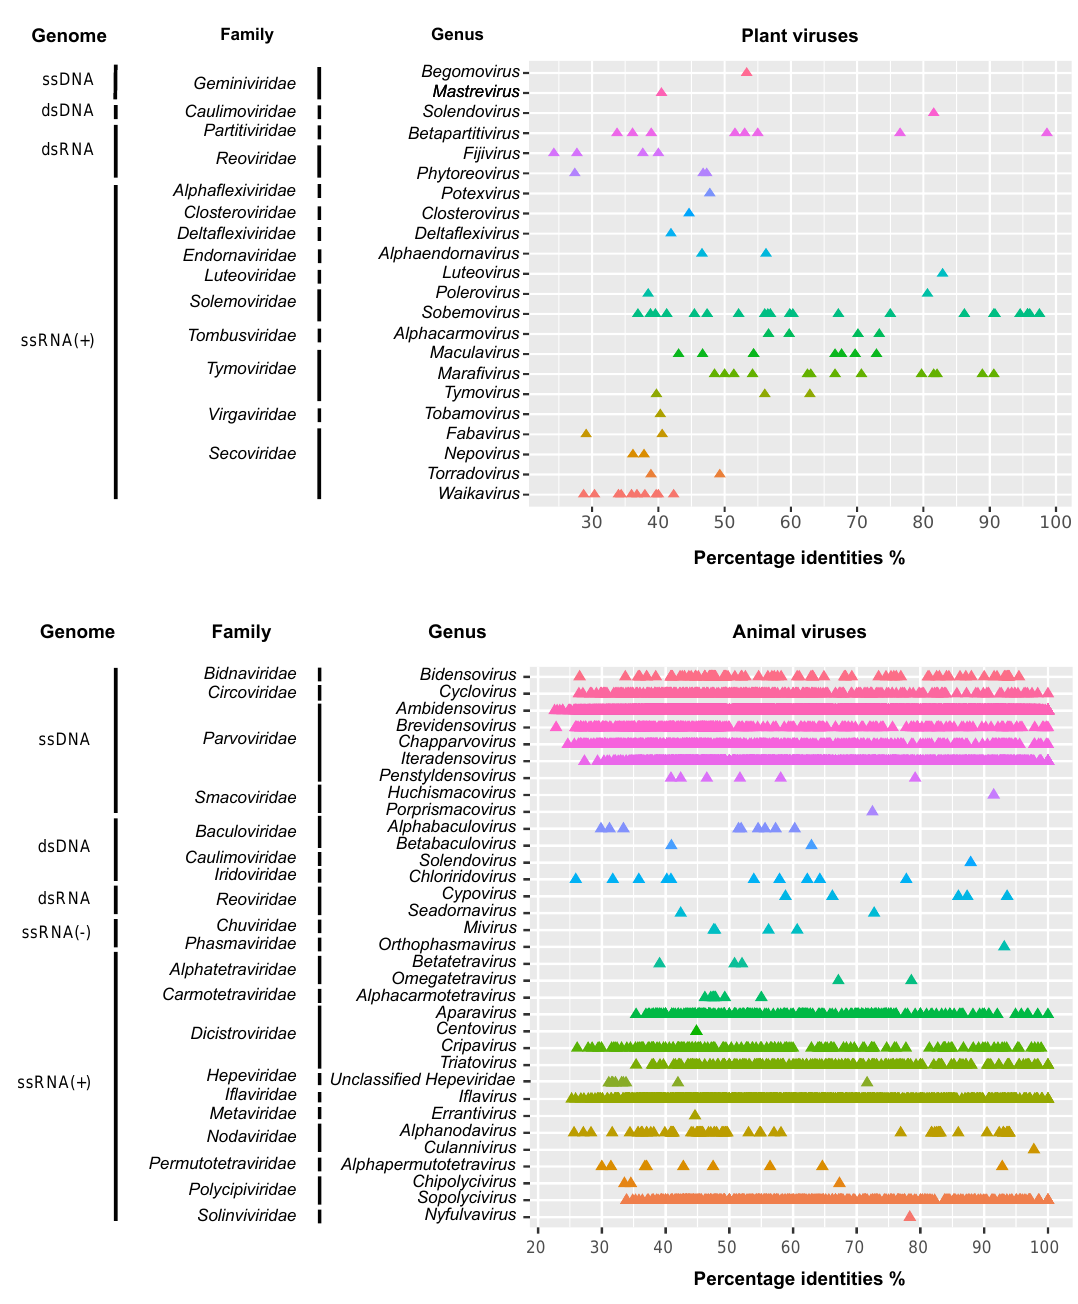
Figure 1 – Sequence identity distribution analysis of viral sequences from the army ant virome. Each dot represents an assembled sequence contig with the corresponding protein identity (best BLASTx e-values < 0.001) to plant (top) and animal virus (bottom) in the GenBank nonredundant